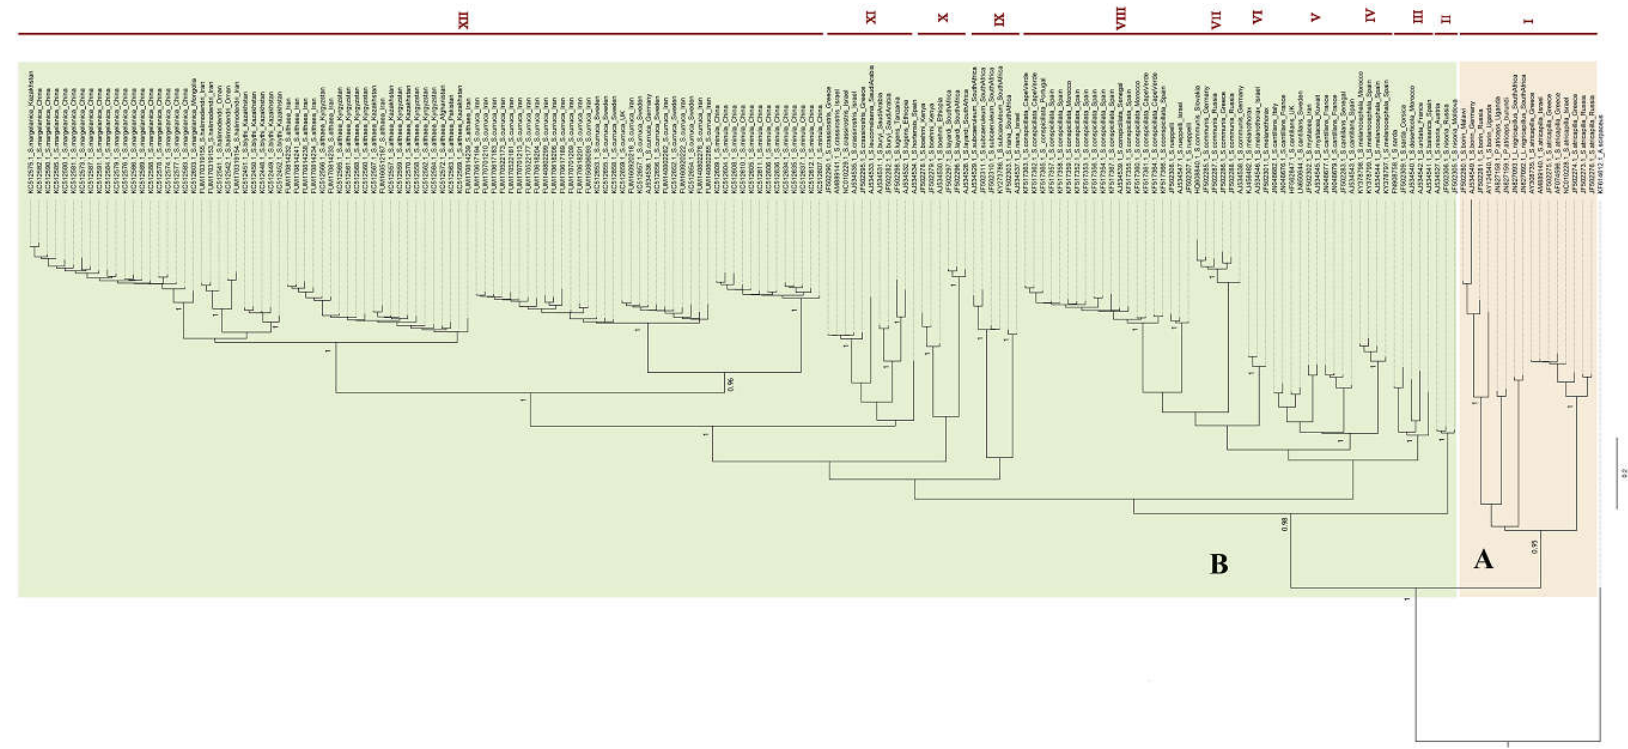
Fig. 2. Phylogeny of Sylvia warblers, based on Bayesian analyses of mitochondrial cytb : Clade A) P. atriceps, L. nigricapillus, S. borin and S. atricapilla ; Clade B) All other species in Sylvia genus . The cytb analysis recovers eight groups (Greek